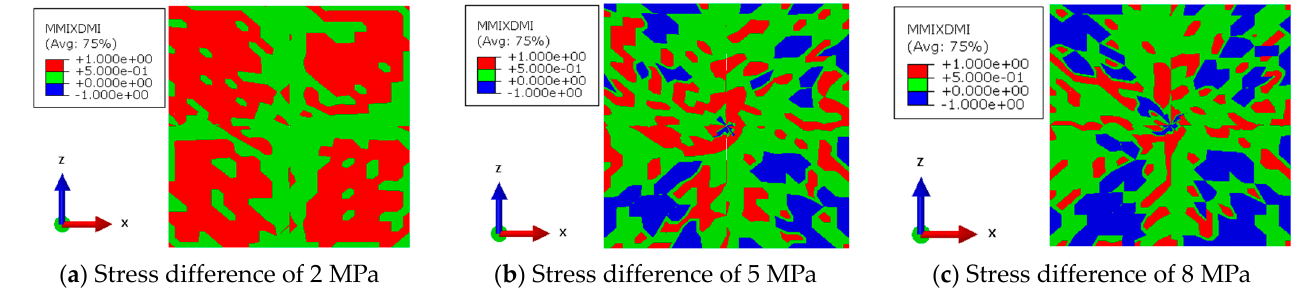
Figure 8. Fracture morphology at the deflagration point under various horizontal stress differences. Table 6. Fracture characterization under variable horizontal stress differences. Stress Difference/MPa